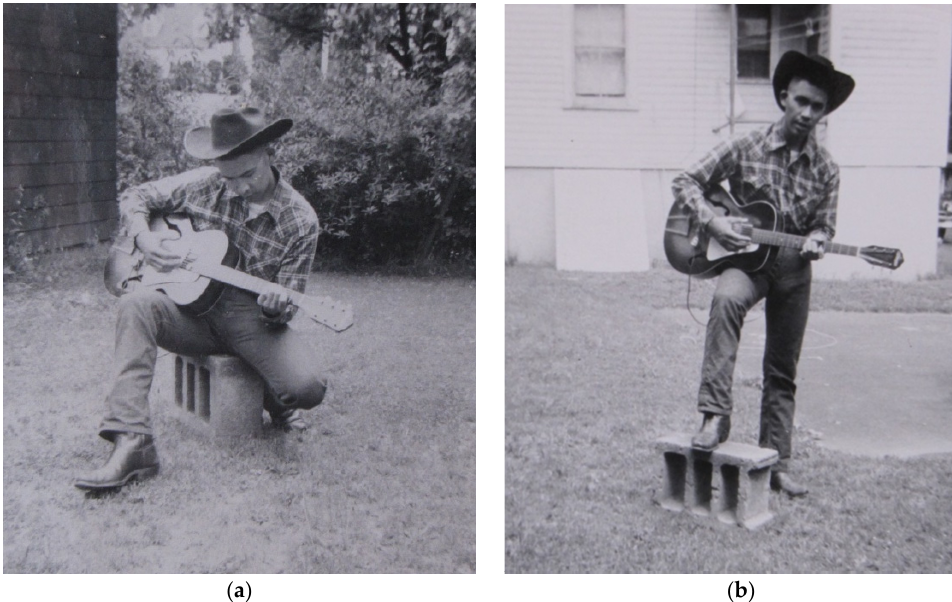
Figure 2. Vine Deloria Jr., posing with guitar, early 1950s. ( a ) Is he playing an E boogie shuffle? ( b ) Is he playing a C-form E7 chord? Author’s collection.